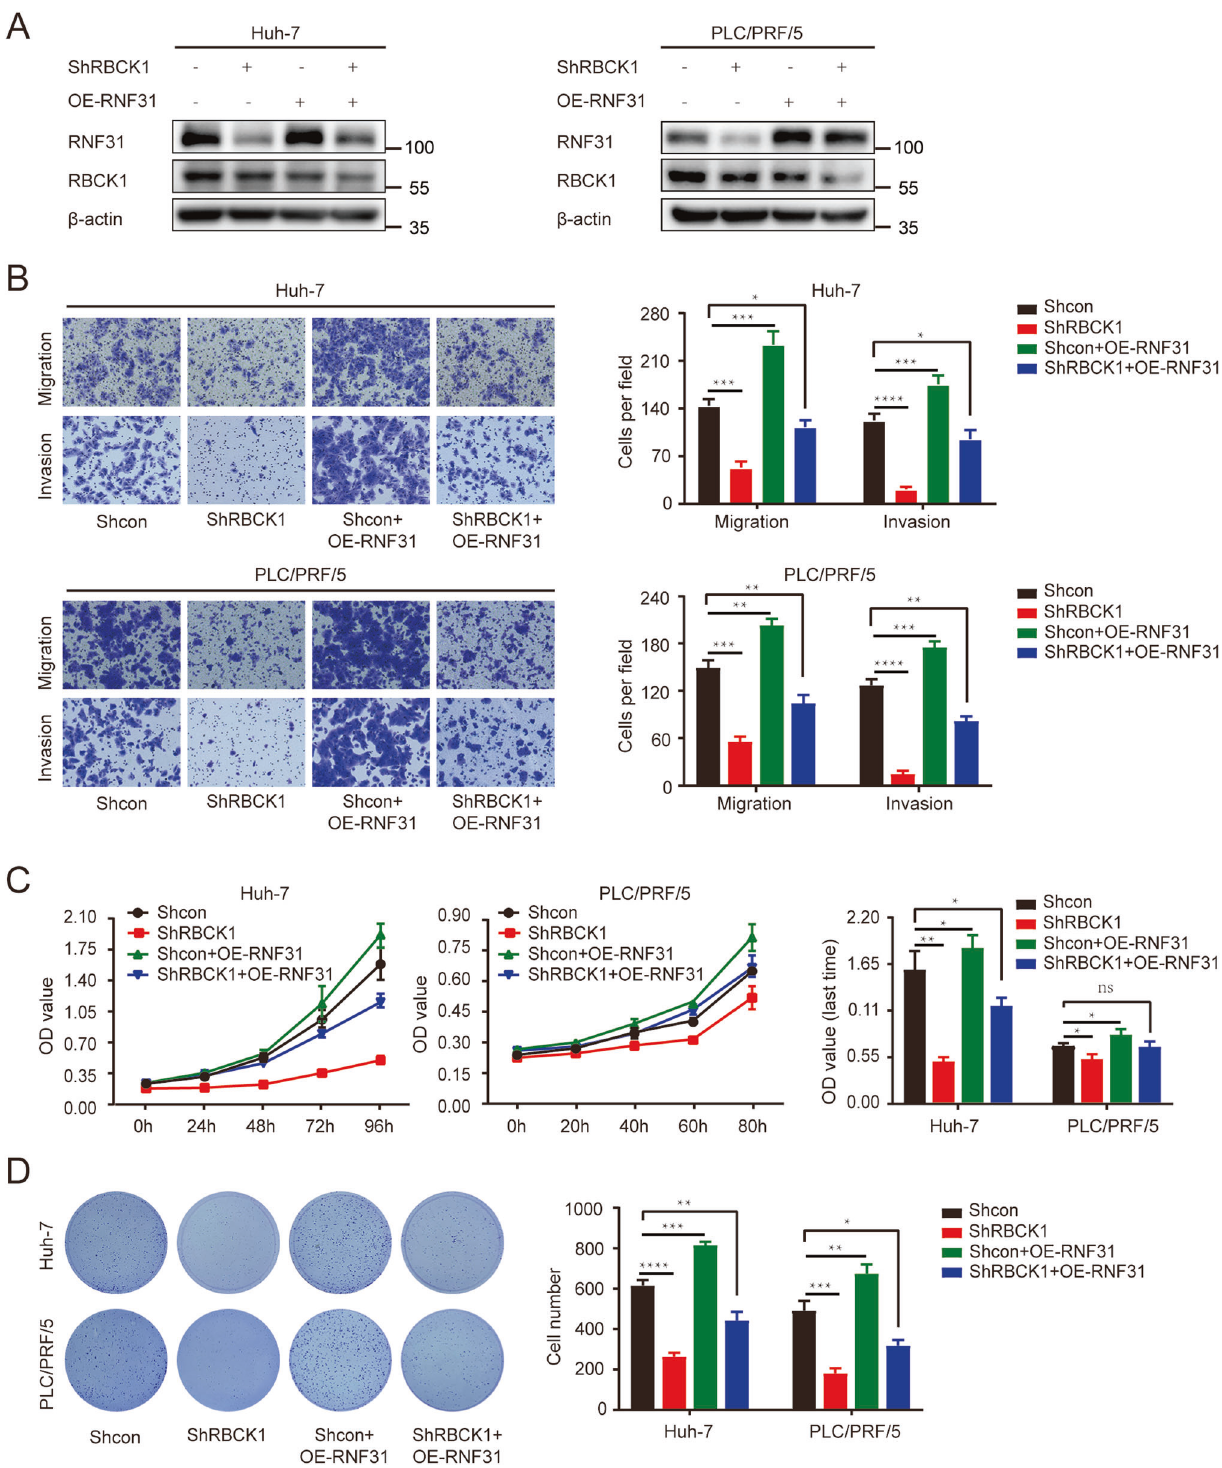
Fig. 6 RBCK1 exerts oncogenic effects partially through regulating RNF31. A The ef fi cacy of reintroducing sh RBCK1 into HCC cells that stably overexpressed exogenous RNF31 was evaluated via western blot. B RNF31 impaired the HCC cell ’ s inhibition of migration and invasion induced by RBCK1 knockdown in PLC/PRF/5 and huh-7 cells as con fi rmed by migration and invasion assays. C RNF31 abolished the proliferation inhibition of HCC cells imposed by RBCK1 knockdown in PLC/PRF/5 and huh-7 cells as con fi rmed by CCK-8 assays. D RNF31 abolished the HCC cell ’ s suppression of proliferation caused by RBCK1 knockdown in PLC/PRF/5 and huh-7 cells as con fi rmed by a colony formation assay. (* p < 0.05, ** p < 0.01, *** p < 0.001, **** p < 0.0001).